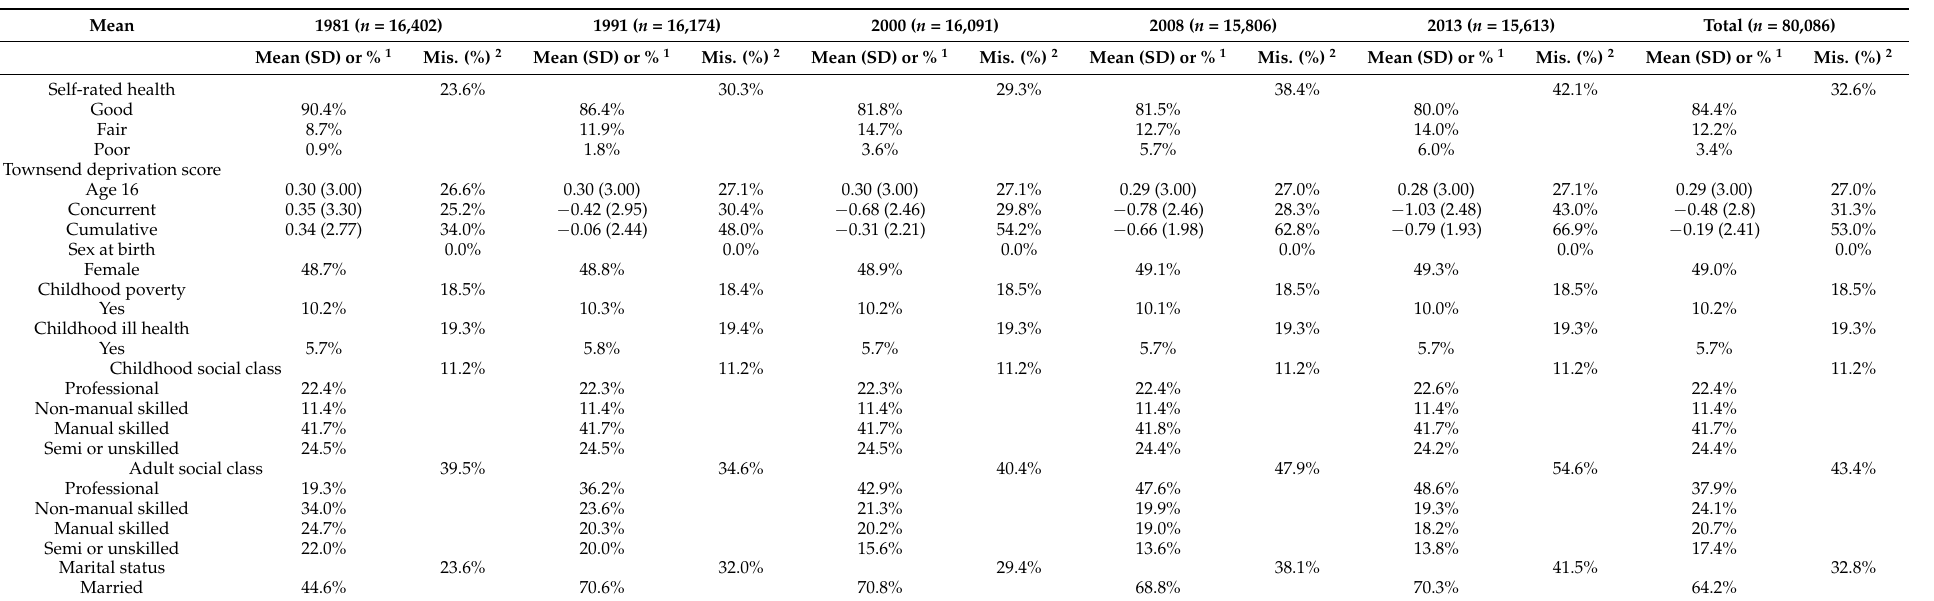
Table 1. Sample characteristics by survey year, National Child Development Study,